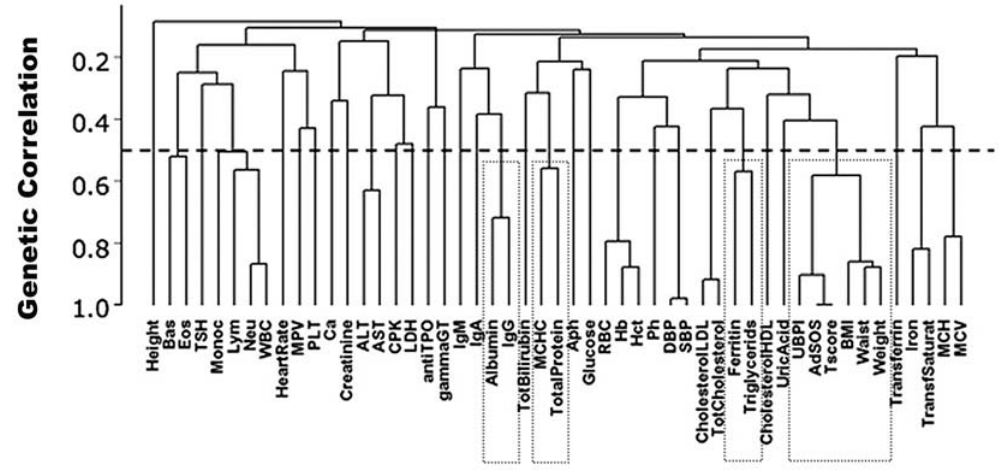
Figure 7. Clusters of genetic correlation. The 52 traits were classified into clusters inferred from genetic correlations between any two traits using the hclust function of R (http://www.r-project.org/). Genetic correlations are indicated on the Y-axis, with the highest correlations toward the bottom. Twelve values exceeded 50% correlation (table S7). Dotted squares highlight not expected genetic correlations. Abbreviations are as in table 1 and 2.